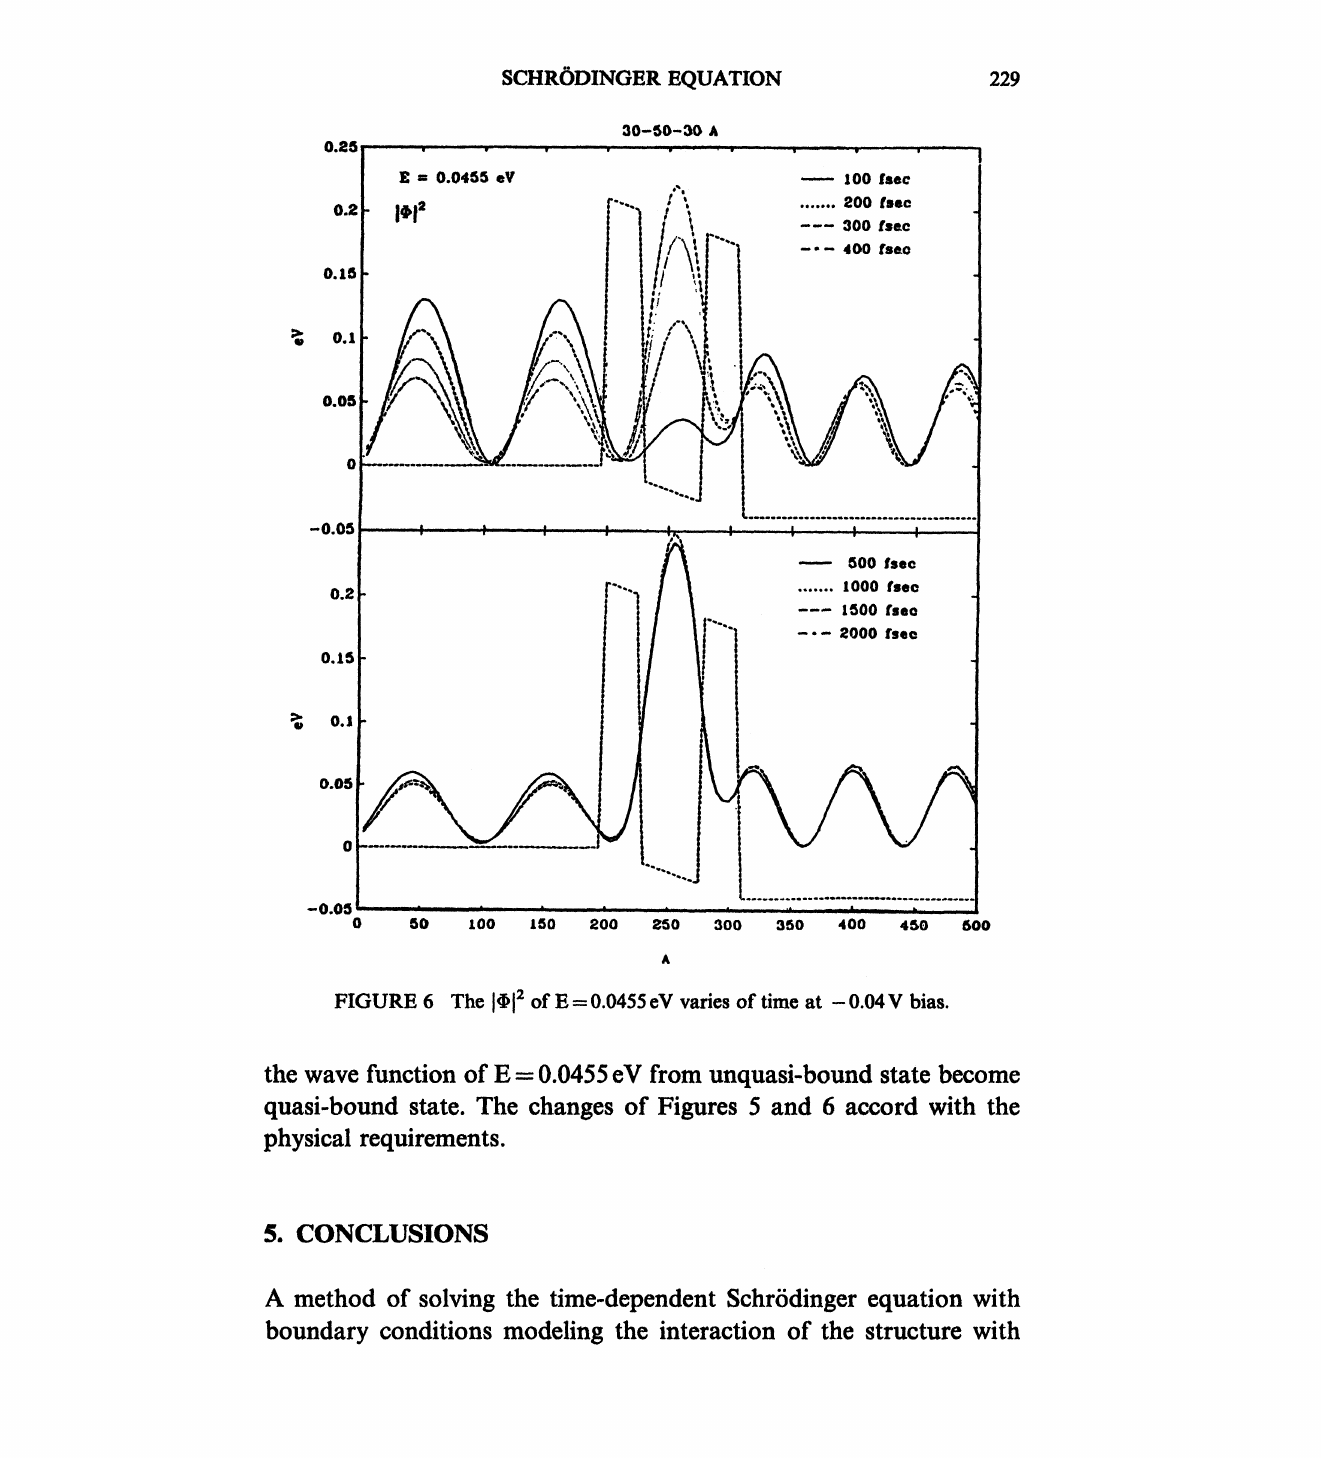
FIGURE 6 The I12 of E=0.0455eV varies of time at -0.04V